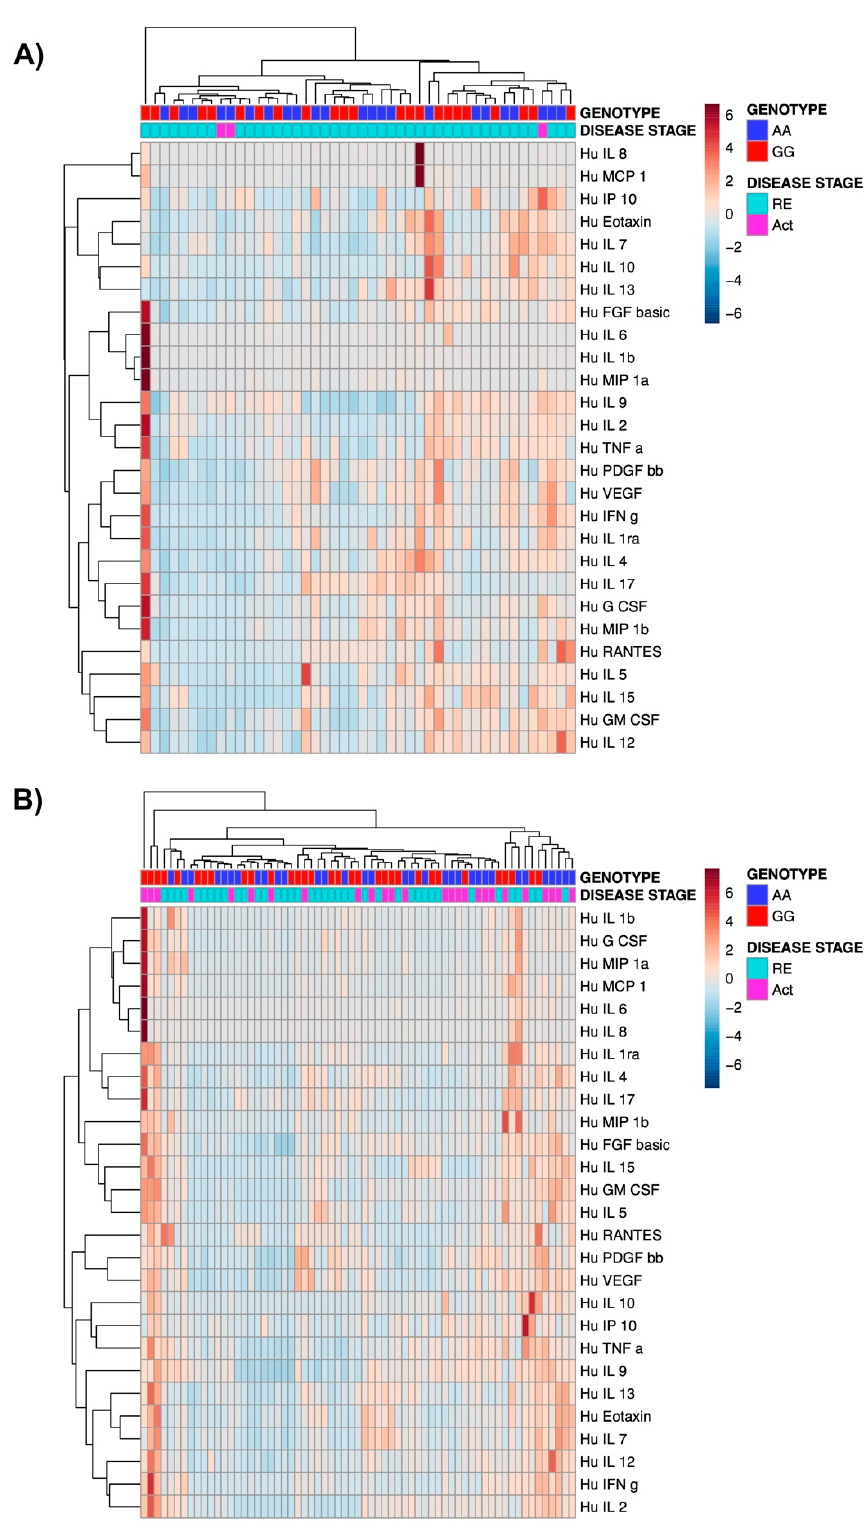
Figure 5. Heatmaps of 27 cytokines measured in serum from both CD ( A ) and UC ( B ) patients. Levels of various cytokines were determined in blood samples from CD and UC patients in active (Act) or remission (RE) state in both wild type and variant using ELISA.